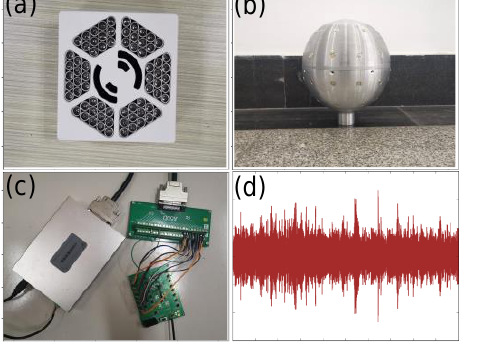
Figure 10. Acquisition of acoustic signals: ( a – c ) are directional speakers, rigid ball microphone array, and acoustic signal acquisition equipment. ( d ) is the collected 10 s acoustic signal expressed in python.